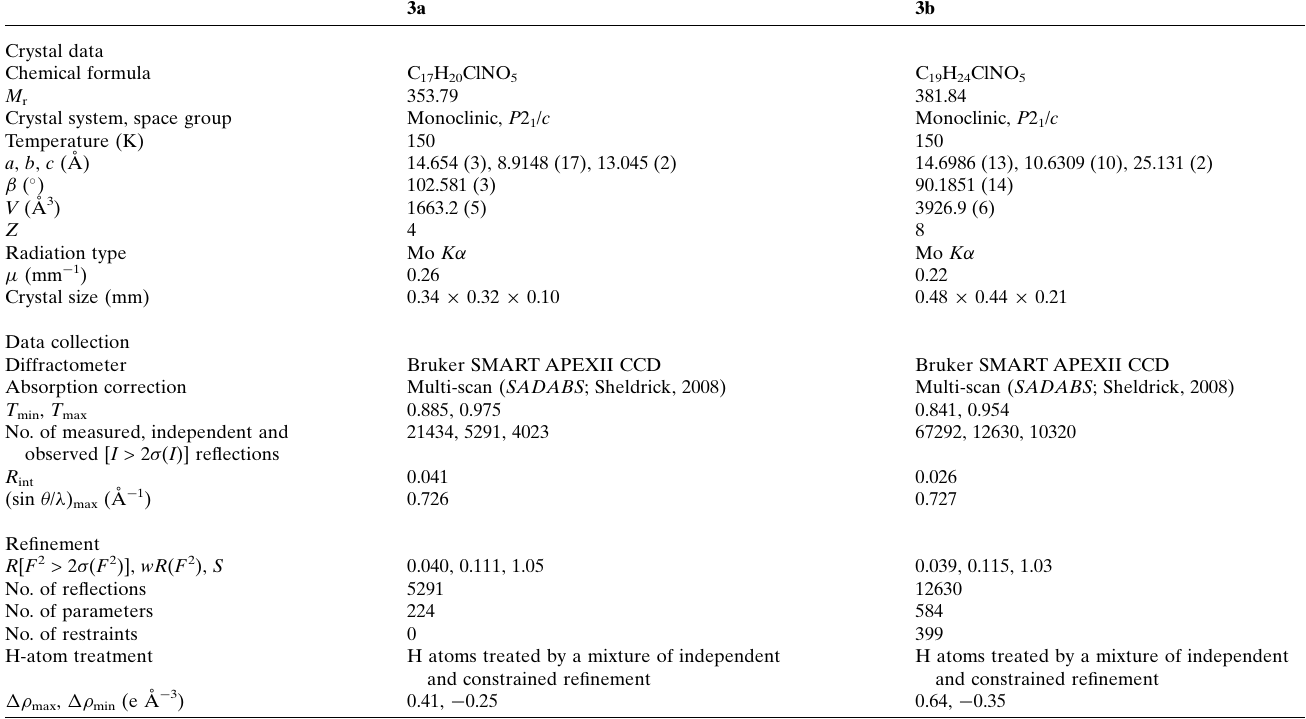
Table 3 Experimental details.